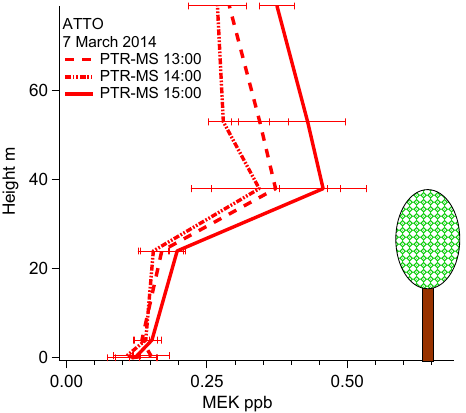
Figure 3. Hourly average vertical profiles of MEK mixing ratios at ATTO for 7 March 2014 for 13:00LT (dashed lines), 14:00LT (dotted and dashed lines) and 15:00LT (thick lines). Error bars of vertical profiles are the standard deviations.